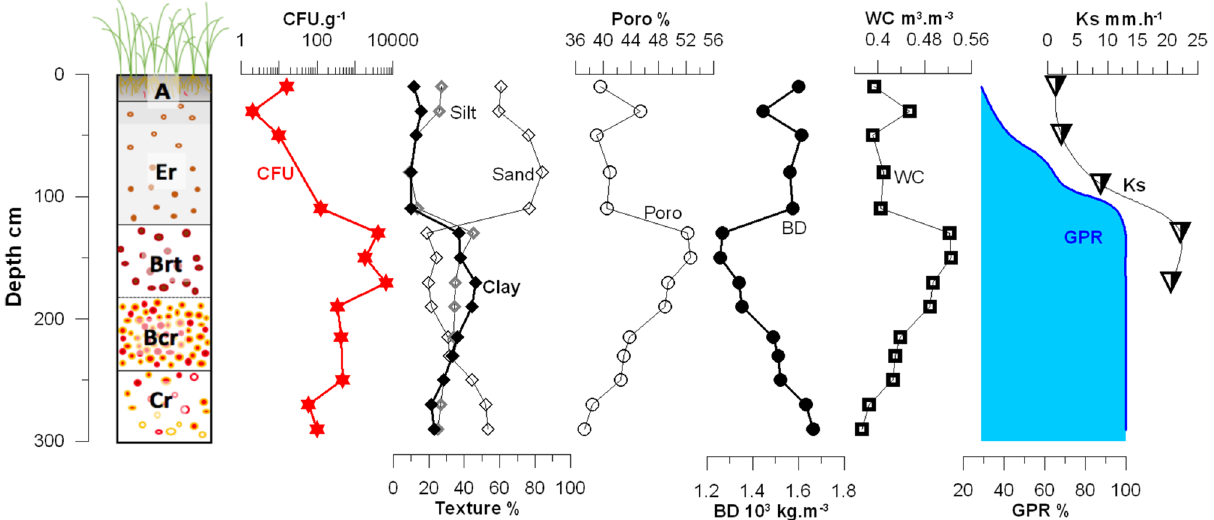
Figure 4. Soil log showing the main pedological horizons (i.e. A, Er, Brt, Bcr and Cr—A = surface (topsoil) horizon; E = eluvium soil horizon (horizon leached of its mineral and/or organic content, B = subsoil horizon (layers which are significantly altered by pedogenesis, mostly with the formation of iron oxides and clay mineral); C = parent material horizon (layer marginally affected by pedogenesis). When indicated, abbreviations for master soil horizon subdivisions are: r = weathered or soft; t = accumulation of silicate clays; c = concretions or hard nodules), semi-quantitative colony forming unit (CFU) counts of B. pseudomallei (CFU g −1 ), and soil physical parameters along the 300-cm deep profile: texture (i.e. percentages of silt, sand and clay), porosity (Poro), bulk density (BD), volumetric water content (WC), groundwater persistence rate (GPR) and saturated hydraulic conductivity